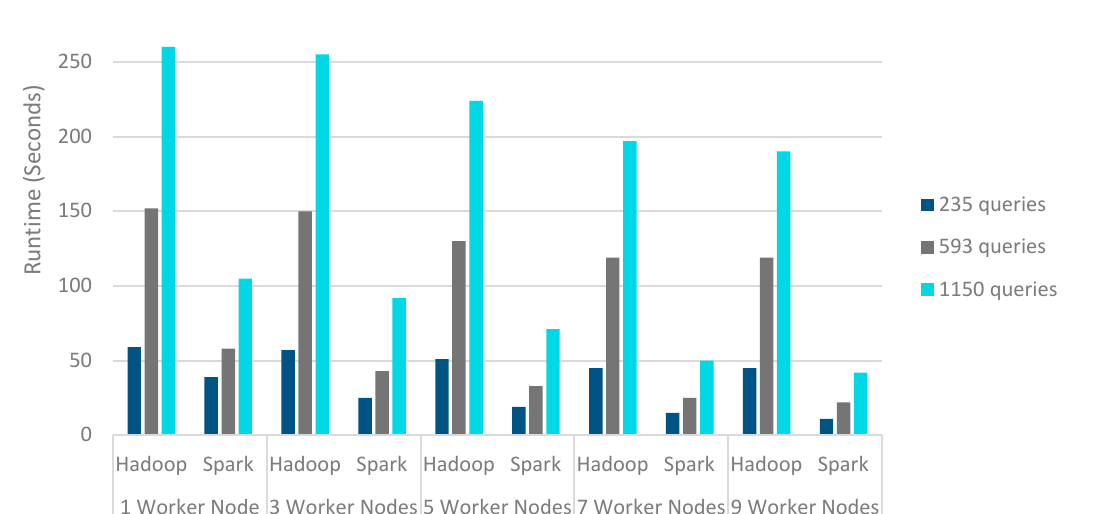
Figure 4. Run-time of Hadoop on different nodes.